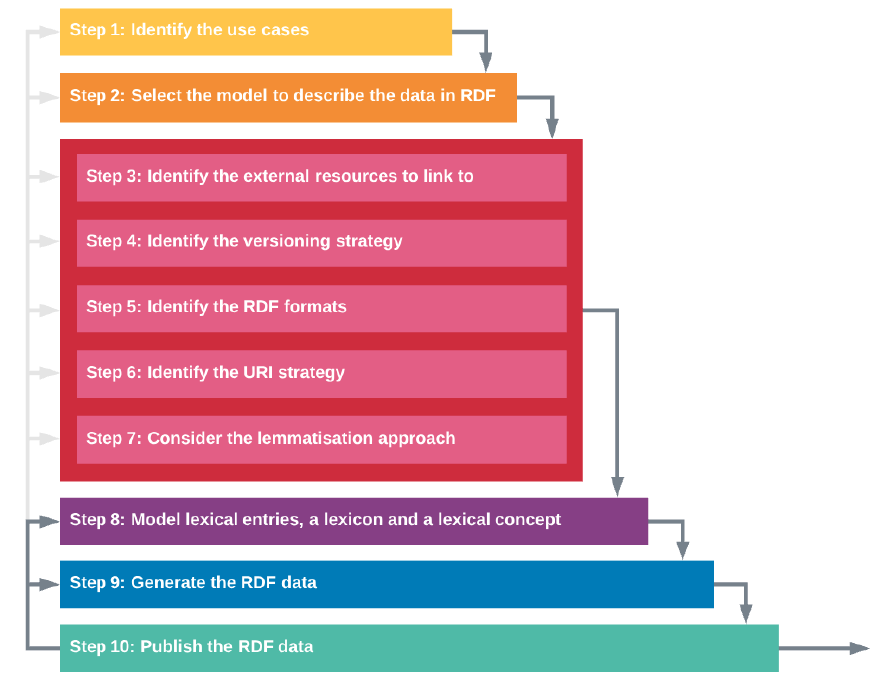
Figure 7. Conversion of a lexicographic resource to a Linguistic Linked Data Framework.